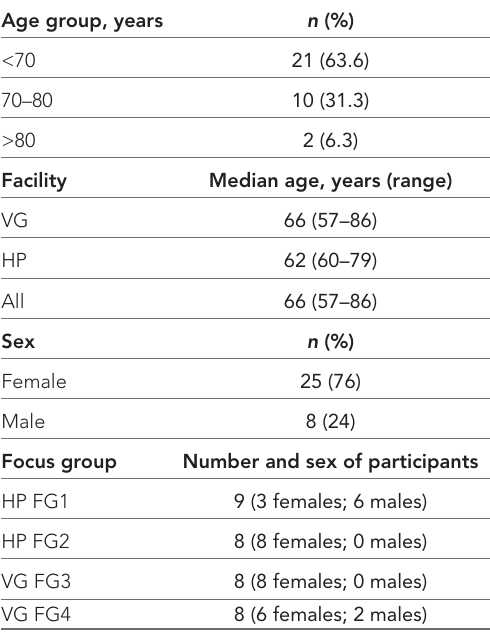
Table 1 Characteristics of study participants (